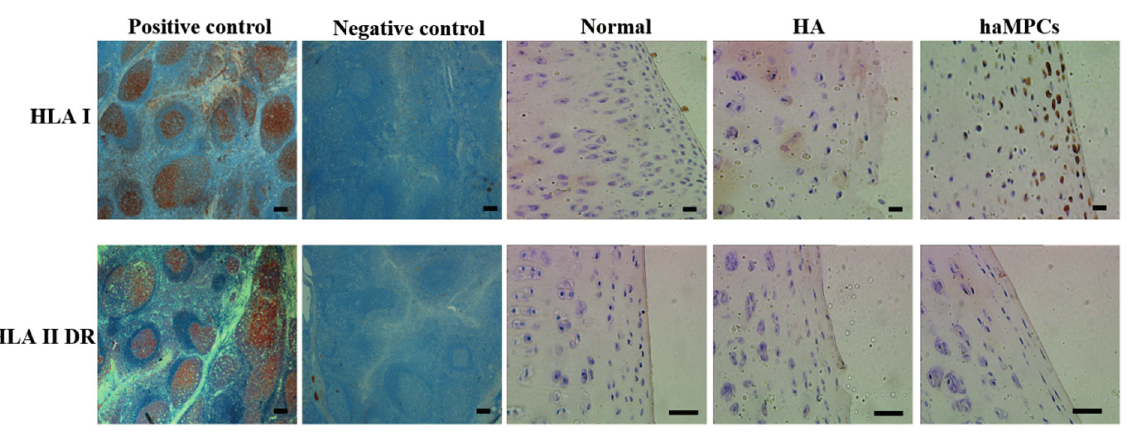
Figure 7. HLA-I but not HLA-II-DR was expressed in haMPC treatment group. In normal and HA treated cartilage, HLA-I and HLA-II-DR were negative. HLA-I but not HLA-II-DR was expressed in haMPC treated cartilage. Immunohistochemical analyses of HLA-I and HLA-II-DR in human tonsil tissue were used as positive control and negative (isotype) control. Scale bars = 50 μ